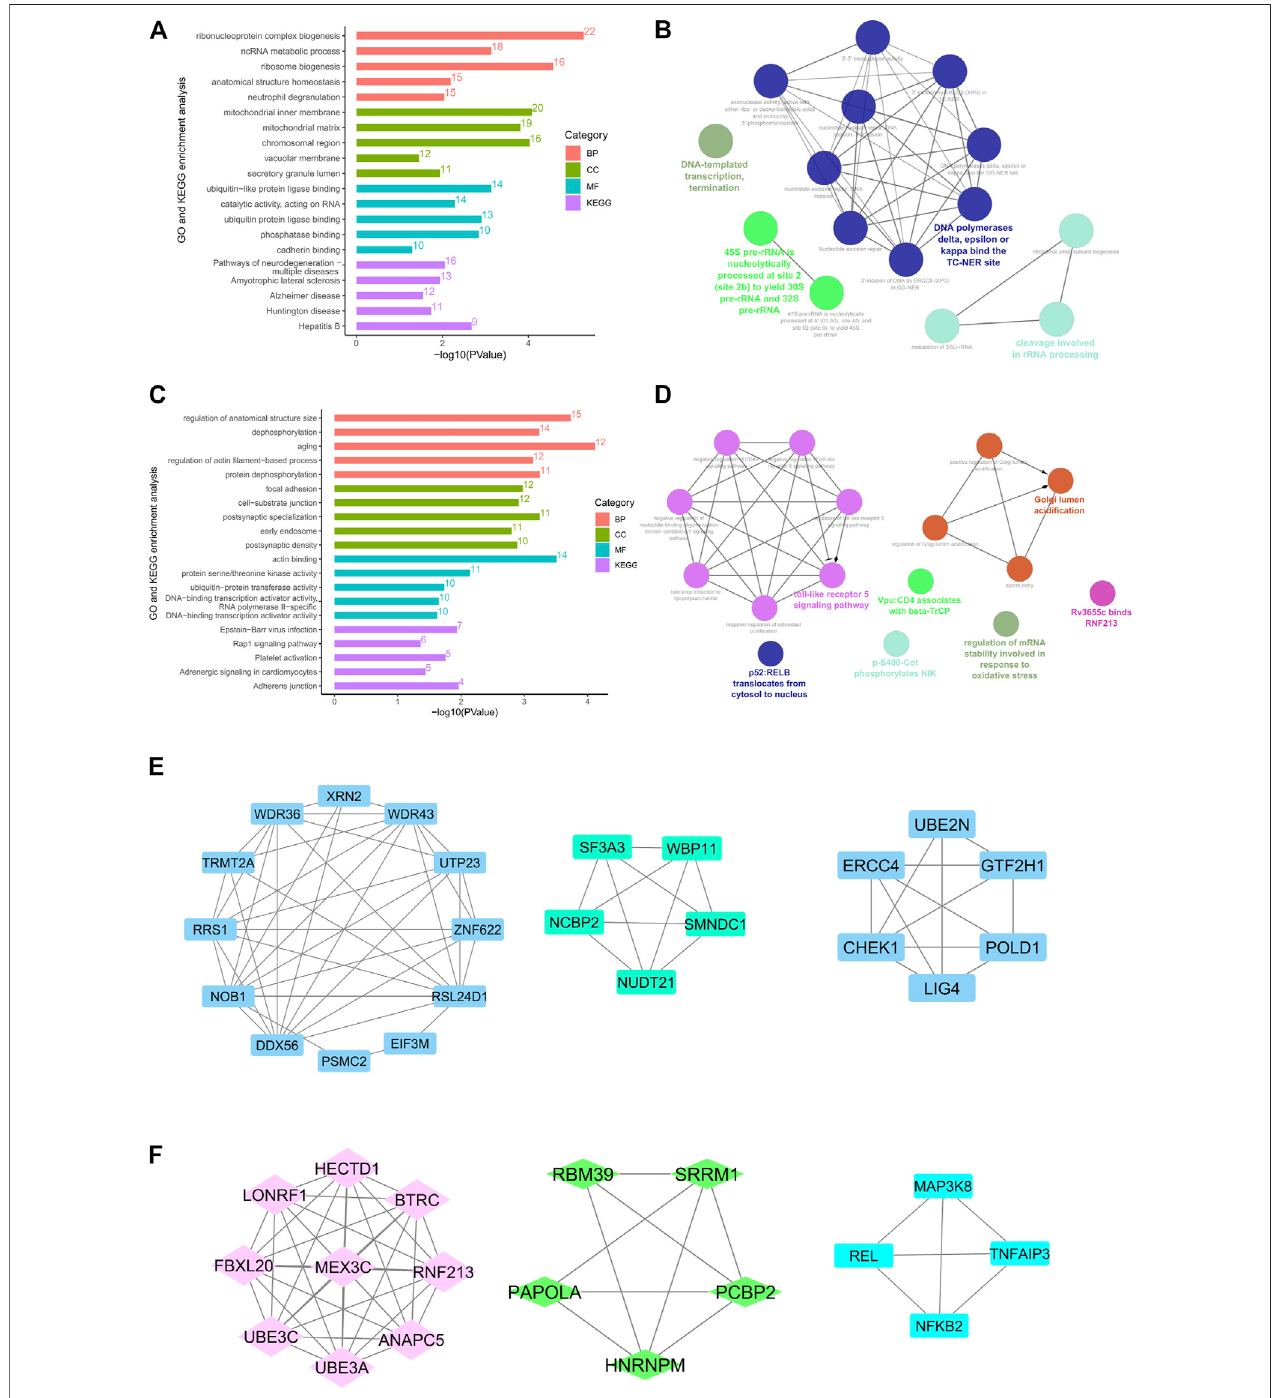
FIGURE4| Theprotein-proteininteraction(PPI)networkandenrichmentbargraphformethylation-relatedDEGs. (AandC) ,GOandKEGGenrichmentbargraph for hypomethylation – up-regulated genes (A) and hypermethylation – down-regulated genes (C) . (B and D) , Reactome and KEGG pathway enrichment visualized by CluoGOofhypomethylationand high-expressionhubgenes (B) and hypermethylationand low-expression hubgenes (D) . (Eand F) ,Topthree modules PPInetworkof hypomethylation – high-expression genes (E) and hypermethylation – low-expression genes (F) .